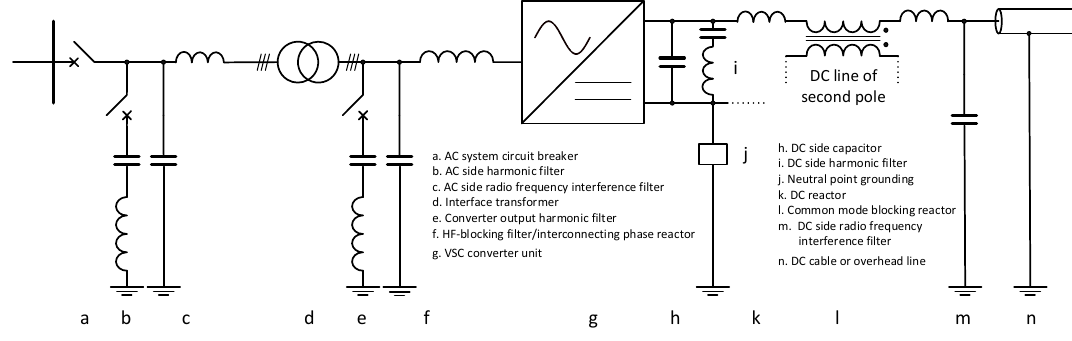
Figure 27. Generic VSC HVDC Converter Station.